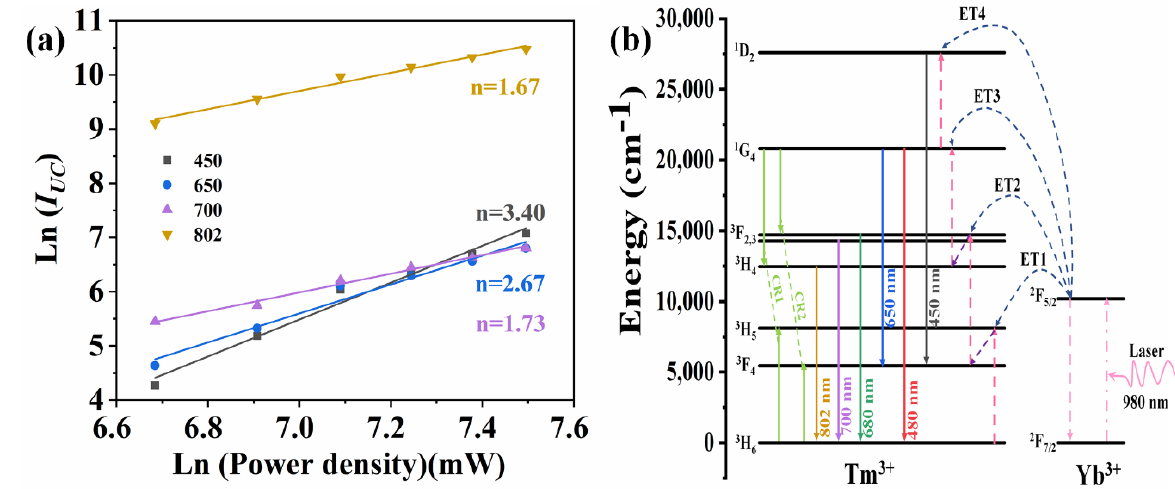
Figure 3. ( a ) Ln-Ln plots of UC emission intensity versus excited power density of 980 nm laser. ( b ) Schematic diagrams of energy levels and relative transitions in KYb 3 F 10 :Tm 3+ GCs.